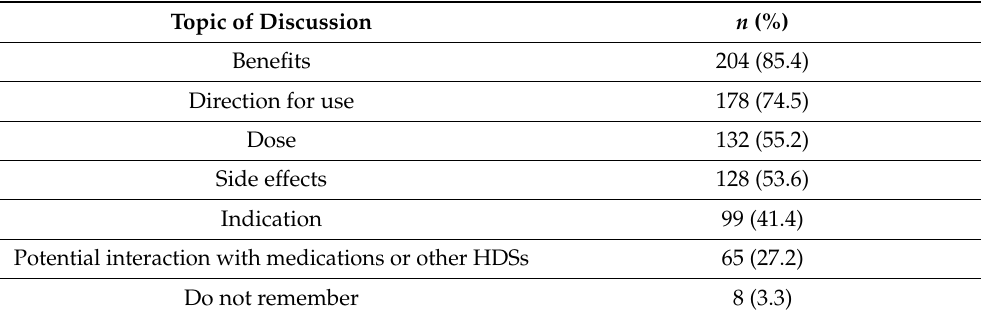
Table 4. The topic of discussion about HDSs during the consultation with CPs ( n = 239).